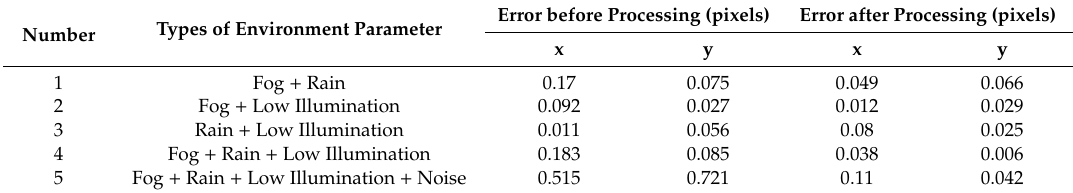
Figure 11. The simulated images before and after processing under the combined interference of multi-environment parameters. Table 3. The positioning results of target center before and after image processing.